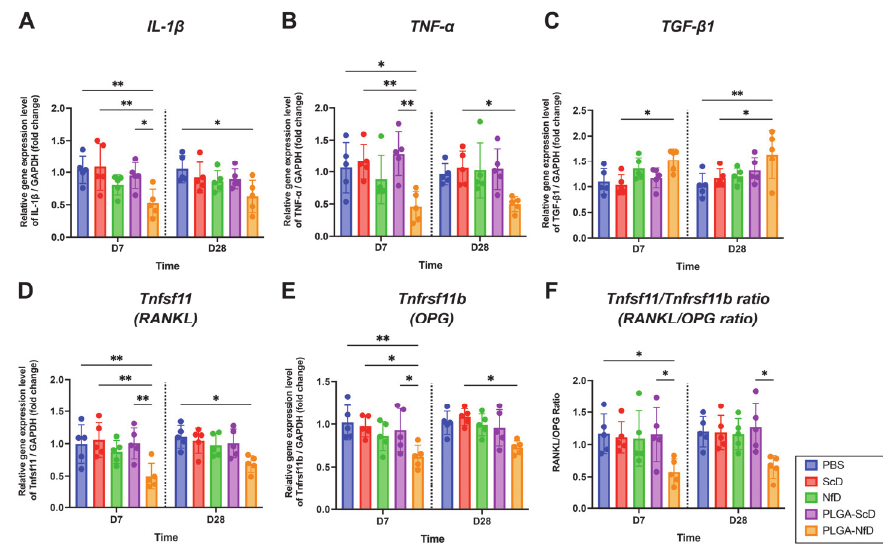
Figure 5. Quantitative real-time polymerase chain reaction analysis of inflammatory cytokines and osteoclastogenic/osteogenesis markers in the alveolar extraction bone tissue on D7 and D28 after tooth extraction. Relative gene expression of ( A ) Il1b , ( B ) Tnf , ( C ) Tgfb1 , ( D ) Tnfsf11 (RANKL), ( E ) Tnfrsf11b (OPG), and ( F ) Tnfsf11/Tnfrsf11b (RANKL/OPG) ratio were determined by reverse transcription quantitative real-time polymerase chain reaction analysis. GAPDH was used as the internal reference. Values are presented as mean ± standard deviation ( n = 5). * p < 0.05, ** p < 0.01. Abbreviations: D7, post-extraction day 7; D28, post-extraction day 28; IL, interleukin; NfD, naked NF- κ B decoy; NF- κ B, nuclear factor-kappa B; ODN, oligodeoxynucleotide; OPG, osteoprotegerin; PBS,